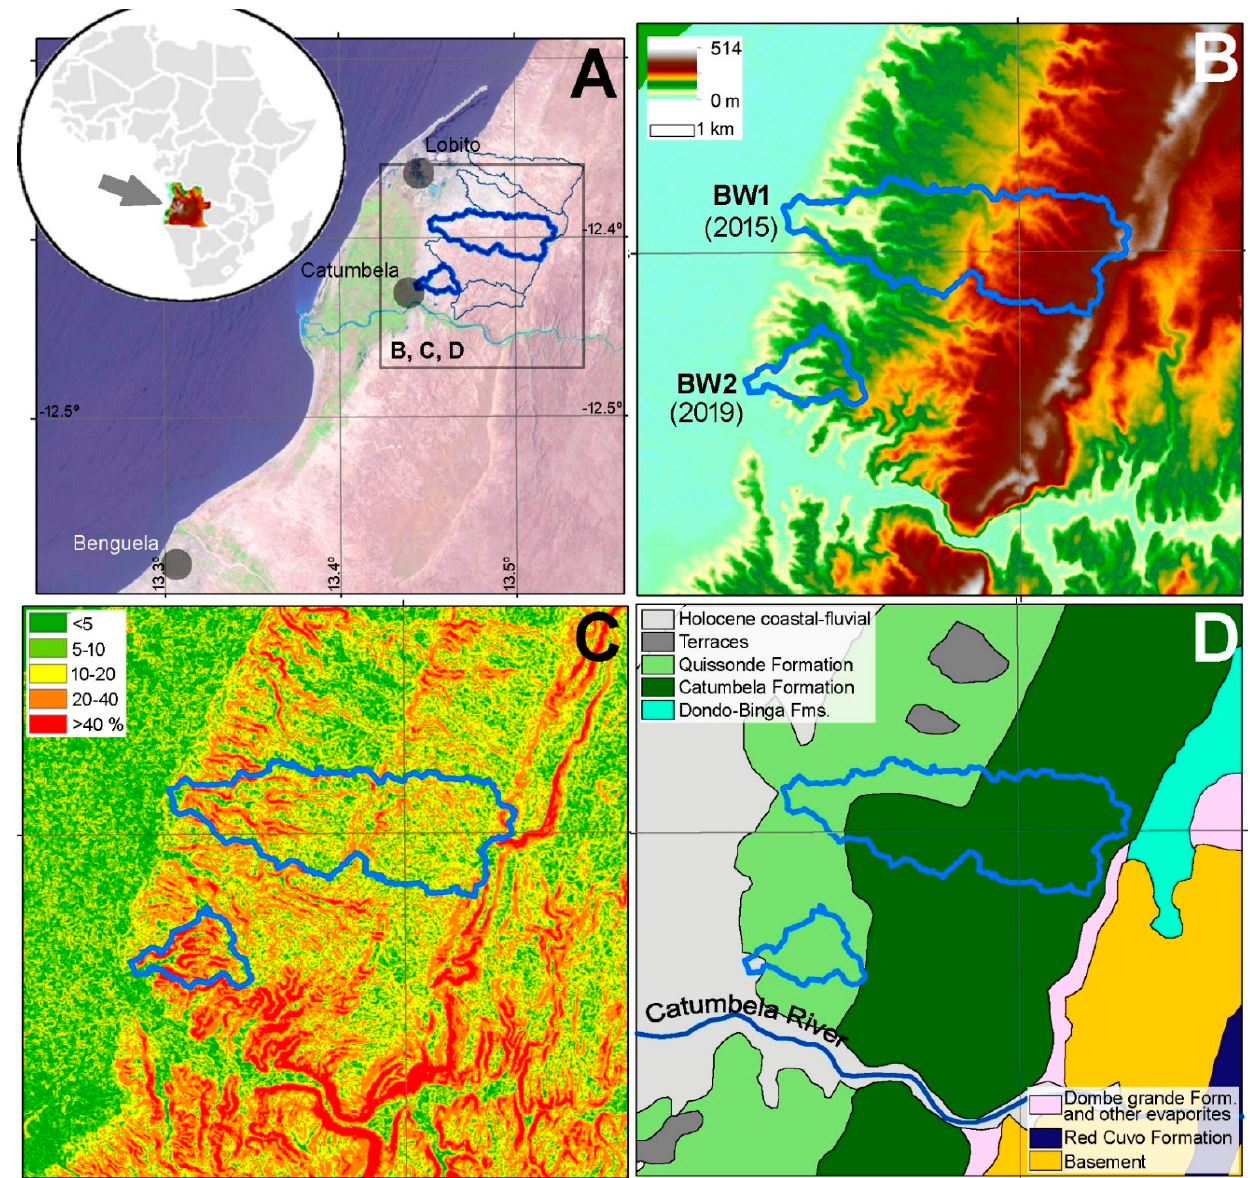
Figure 1. General features of the study area. ( A ) Location of the study area and affected catchments in SW Angola; other comparable coastal catchments are drawn with thinner line. Elevation ( B ) and slope ( C ) maps obtained with a Digital Elevation Model from SPOT. ( D ) Geological sketch redrawn from Guiraud and colleagues [32].